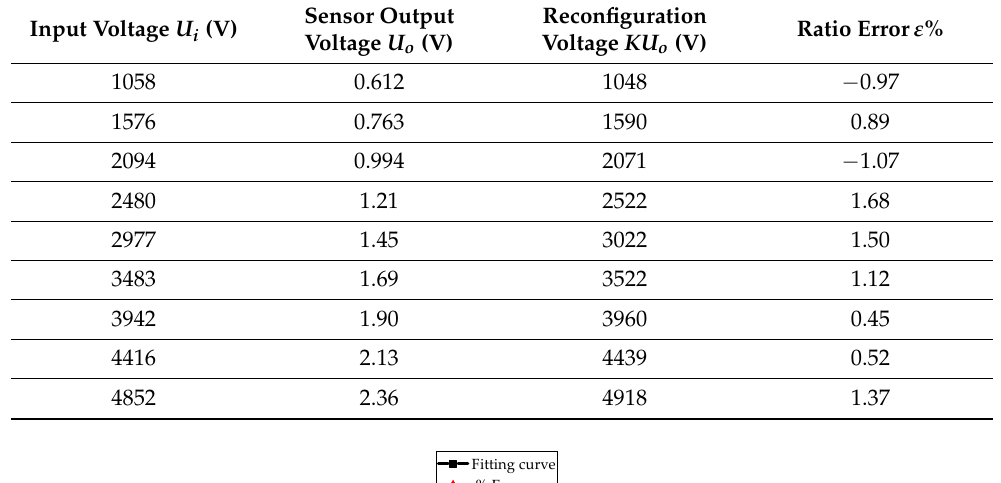
Table 4. High-voltage performance test input and output voltage and ratio error calculation results.